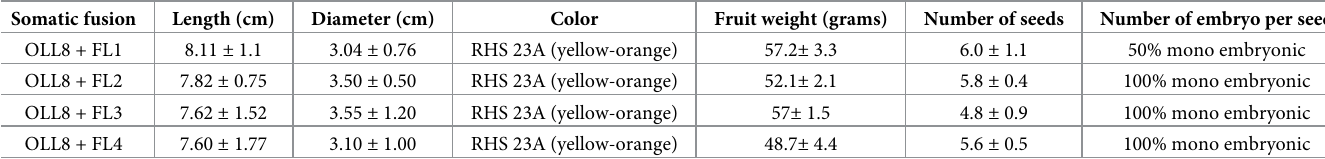
Table 3. Average fruit characteristics of the different OLL8+FL somatic fusions.